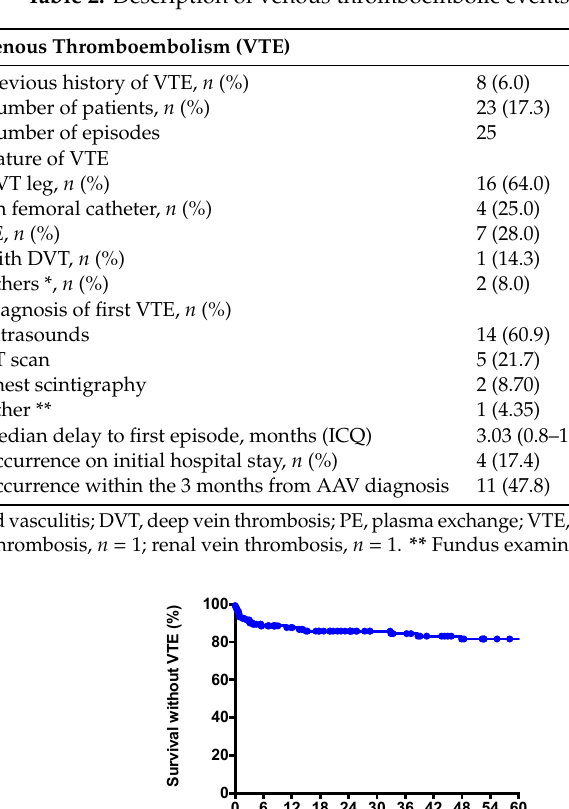
Table 2. Description of venous thromboembolic events.